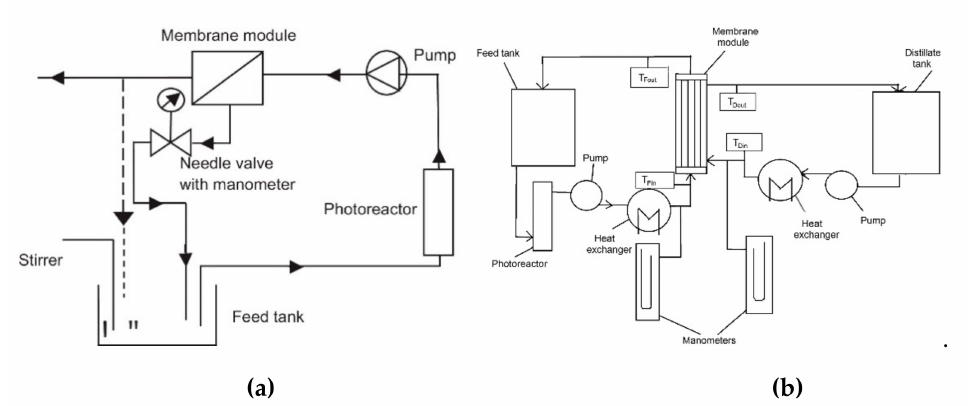
Figure 1. Schematic diagram utilizing ultrafiltration (UF) ( a ) and direct contact membrane distillation (DCMD) ( b )